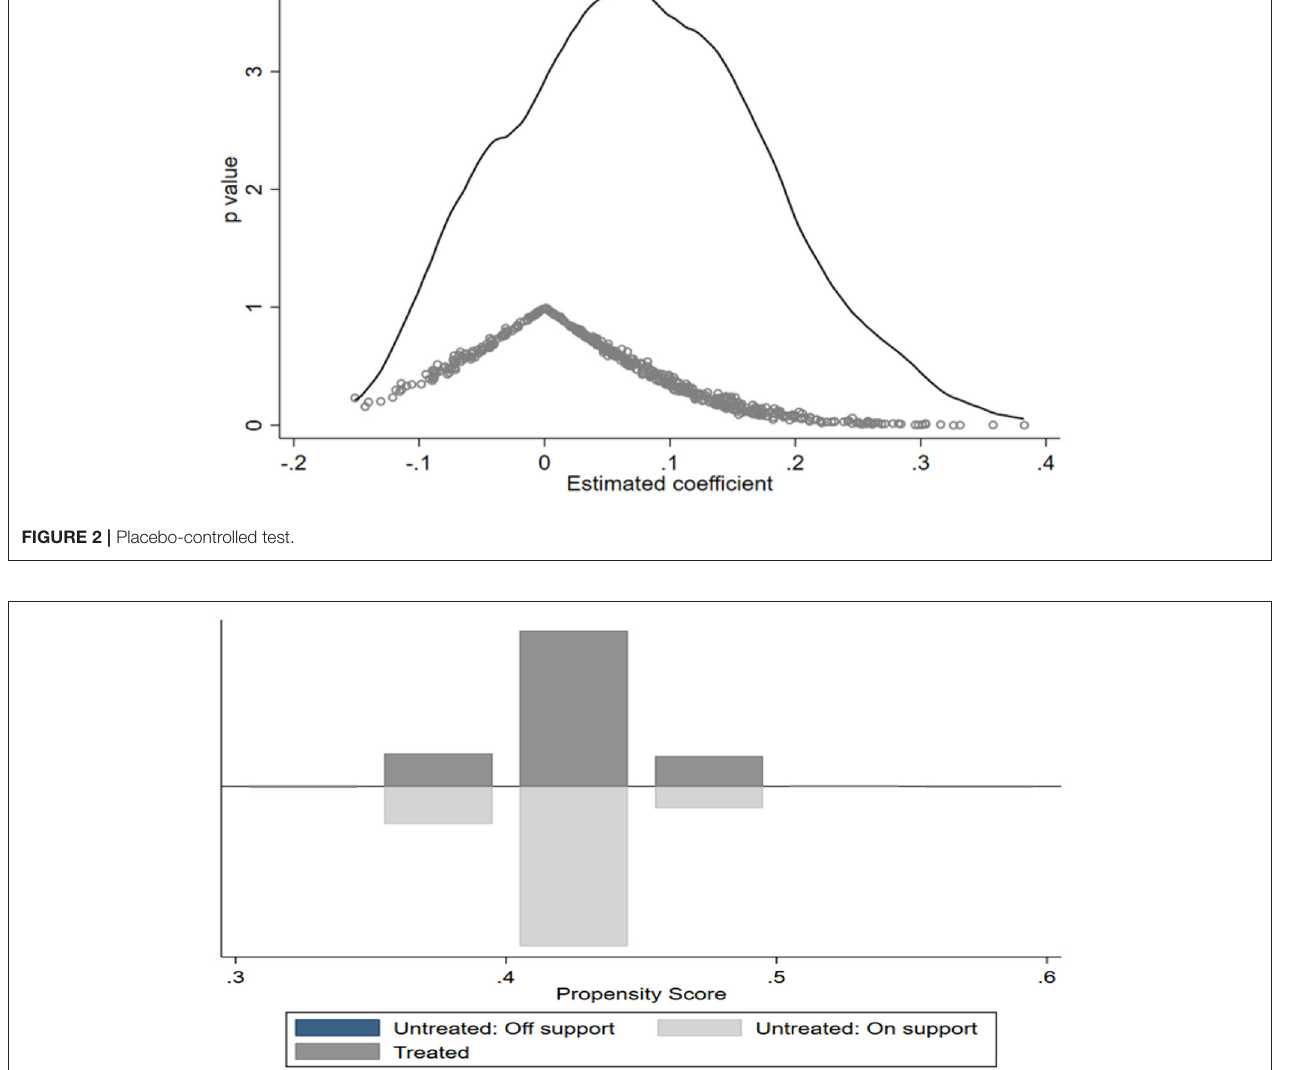
FIGURE 3 | Overlapping assumption